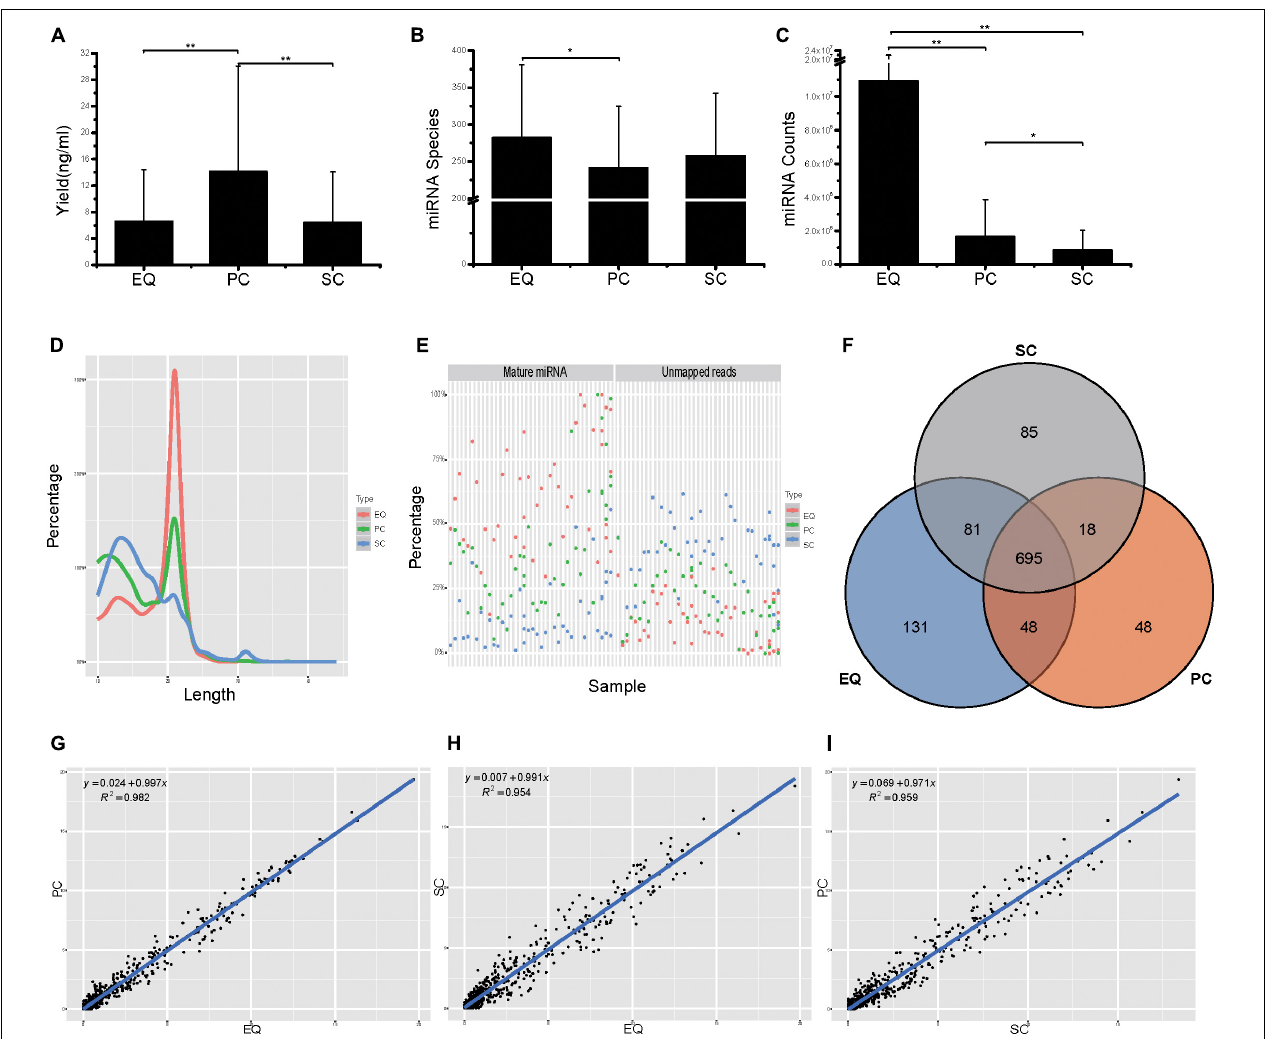
FIGURE 5 | Analysis of the differences in exosomal miRNA profiles among three isolation methods. (A) Small RNA yield efficiency by three methods. (B) Identified miRNA species by three methods, average of miRNA species from 46 samples. (C) MiRNA total counts by three methods, average of total miRNA counts from 46 samples. (D) Average read length distribution by three methods. (E) Aligned miRNA reads and unmapped reads of 46 samples by three methods. (F) Venn diagram presents all identified miRNAs that are common or unique in the three method datasets. Most (695) miRNAs were common to the three sets. (G–I) , Scatter plots reveal correlations between EQ and PC (D) , EQ and SC (E) , SC and PC (F) . Each scatter plot represents relative expression of miRNA profiles obtained by two methods. * represents p < 0.05 in Student’s T- test. ** represents p < 0.01 in Student’s T